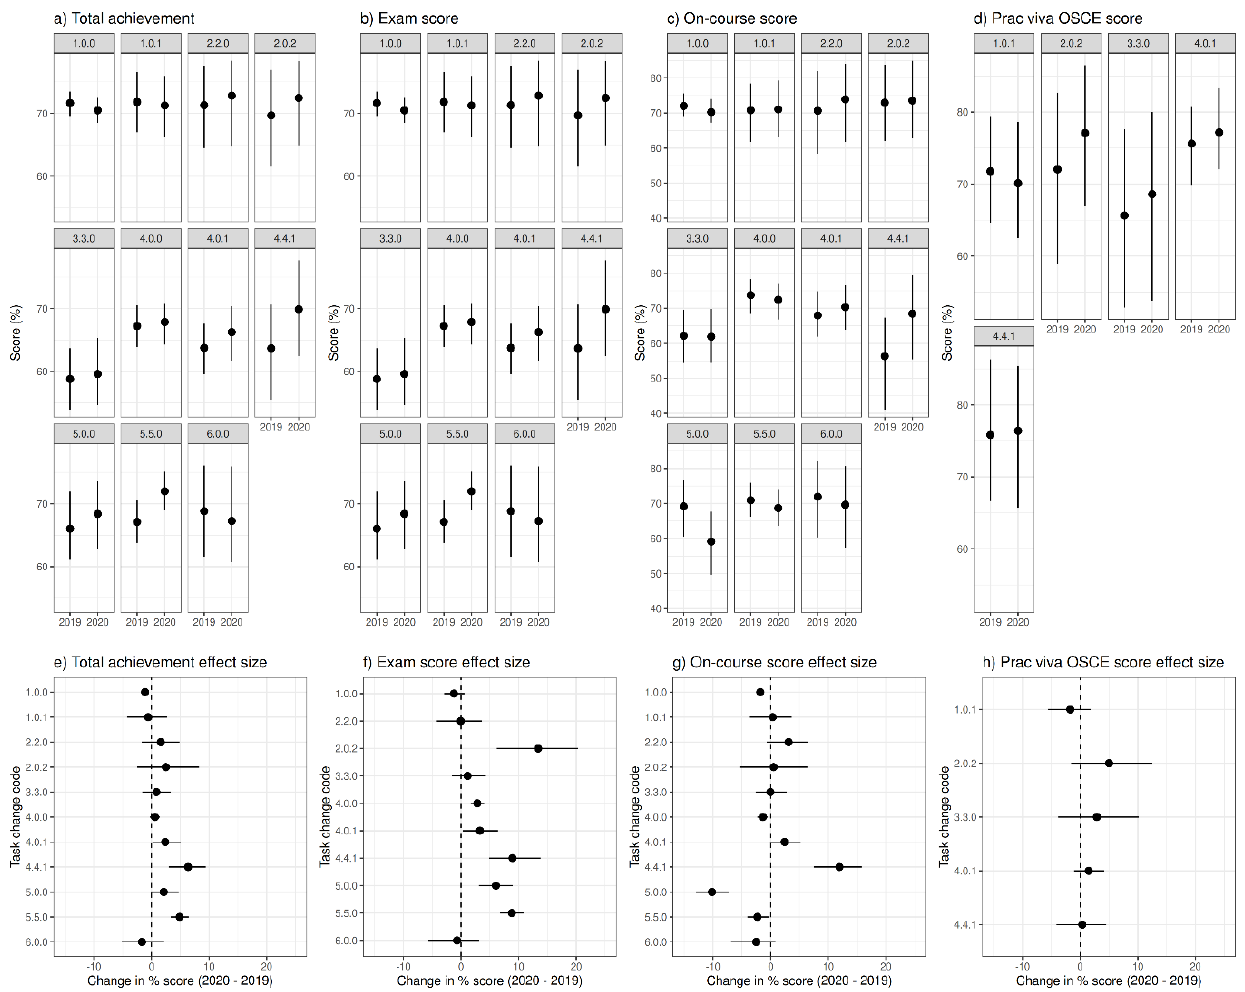
Figure 1 provides a 2019 (normal) versus 2020 (COVID switch) comparative display of mean student performance and percentage change effect size (2020 minus 2019) for total achievement (subject score; Fig 1 (a), Fig 1 (e)), and the sub- assessment categories of exam score (Fig 1 (b), Fig 1 (f), on-course score (Fig 1 (c) and Fig 1 (g)), and prac/Viva/OSCE (Fig 1 (d) and Fig 1